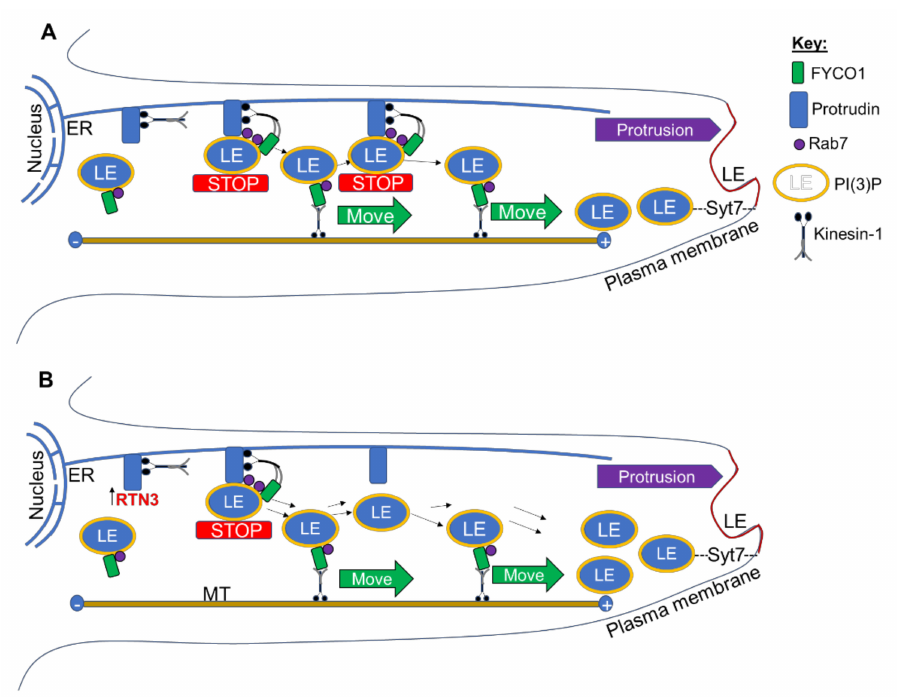
Figure 9. ( A ) Endoplasmic reticulum (ER)-localised protrudin forms contact sites with late endosomes (LEs) after detection of Rab7 and phosphoinositide 3 phosphate PI(3)P (yellow) and stopping the movement of LE (STOP). Kinesin-1 bound to protrudin is then handed over to the LE protein FYCO1, which mediates plus-end (+)-directed LE movement (MOVE) along microtubules (MT) to the periphery. Synaptotagmin 7 (SYT7)-mediated LE fusion with the plasma membrane then enables protrusion formation and neurite outgrowth, as previously proposed [14,57]. ( B ) Overexpression of RTN3 allows the handover of kinesin-1 to occur more rapidly and hence greater numbers of LEs available for protrusion (neurites/axons) at the plasma